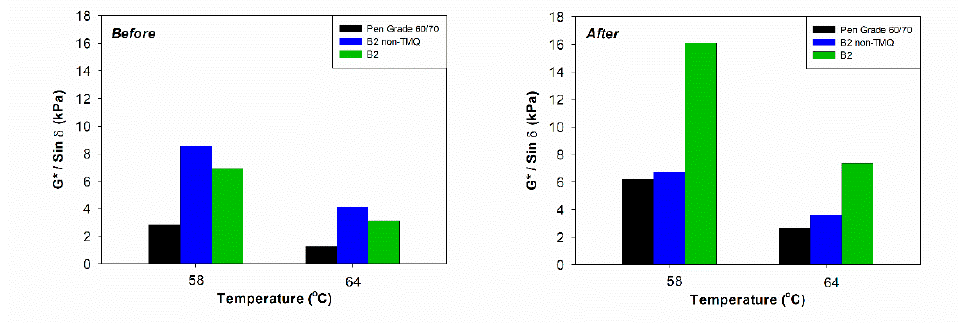
Figure 9. Factor rutting before and after RTFOT.